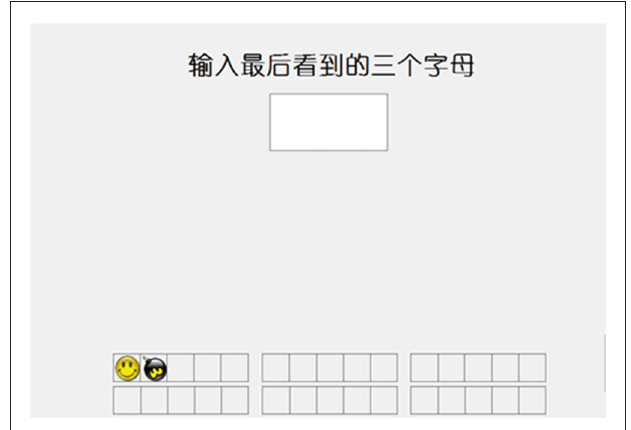
FIGURE 1 | Demonstration of letters running working memory (WM) task.